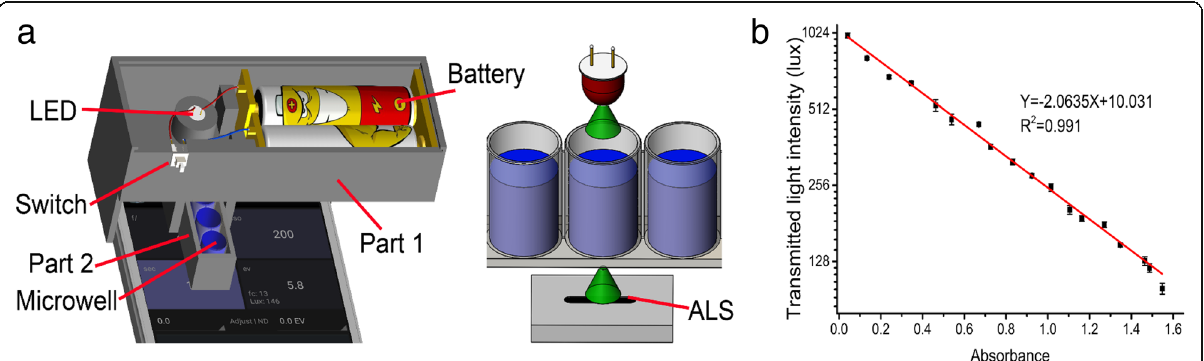
Fig. 3 Mechanism of smart phone-based plasmonic immunoassay reader. a Schematic of the 3D-printed accessory of smart phone-based plasmonic immunoassay reader. Transmitted light intensity of AuNRs was measured by ALS of the smart phone and the value was displayed onto a screen. b The correlation between results from the smart phone based plasmonic immunoassay reader and those from the commercial microplate reader. Each value presents the mean from three